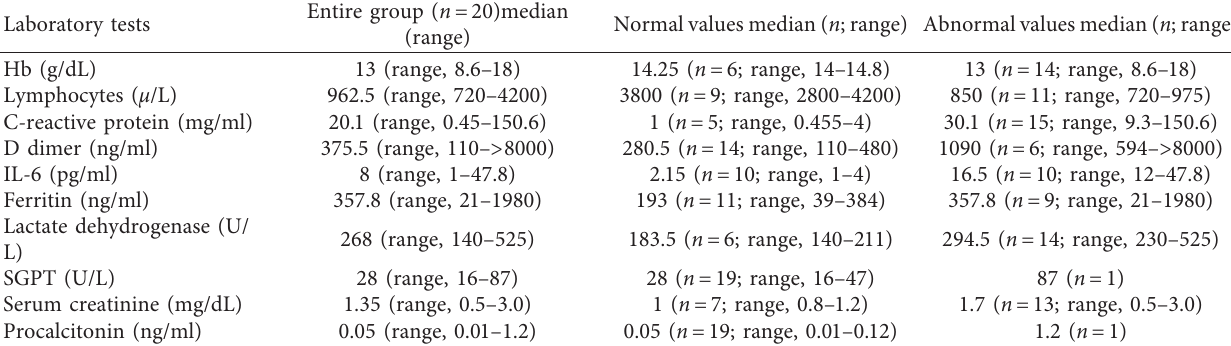
Table 3: Laboratory findings of kidney transplant recipients with SARS-CoV-2 infection.